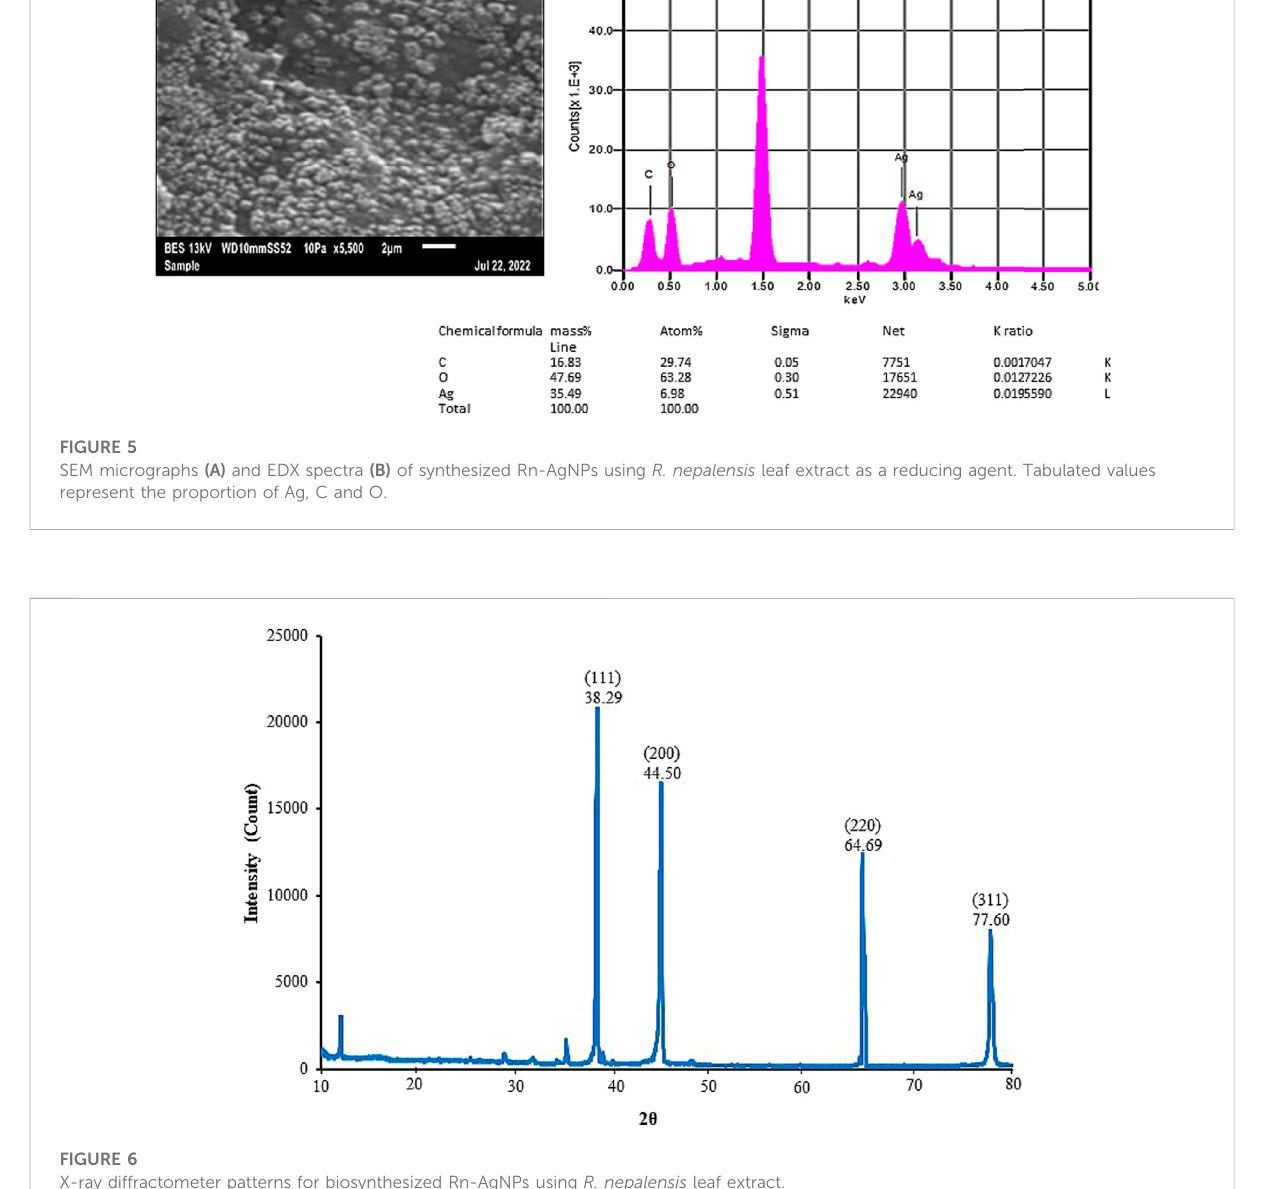
Frontiers in Molecular